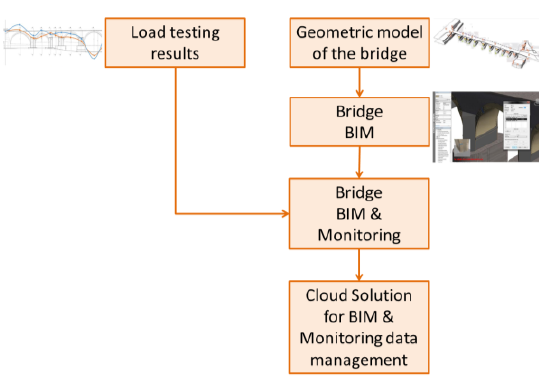
Figure 2. Workflow of the proposed integration approach During the modelling phase, a set of benchmarks was generated to associate them the measurements carried out during the load testing phase. For the definition of the vertical displacements of the bridge during the test, a levelling network was established to define the displacements of a set of benchmarks connected to the structure. Displacement measurements of benchmarks are then linked to the “virtual benchmarks” created in the BIM model of the bridge. Finally, the resulting informative model is shared with a BIM cloud